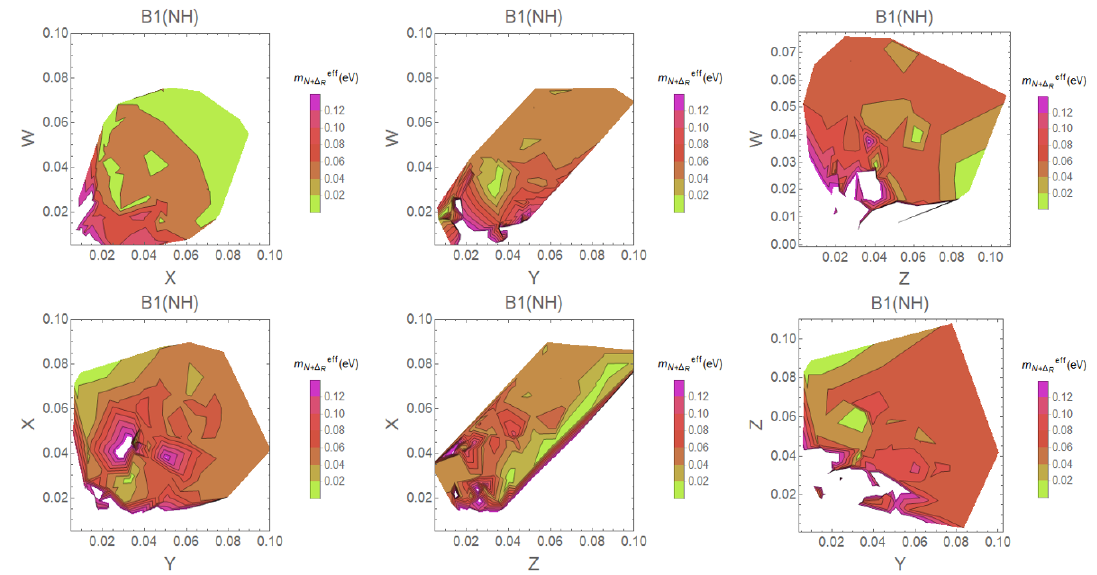
Figure 12 . The various combinations of type II SS model parameters (in eV) with the new physics contribution to e(cid:11)ective mass as the contour, where 0.061 eV is the KamLAND-Zen upper limit in B1 class of two texture zero neutrino mass matrix for normal hierarchy. Figure 13 . The various combinations of type II SS model parameters (in eV) with the new physics contribution to e(cid:11)ective mass as the contour, where 0.061 eV is the KamLAND-Zen upper limit in B1 class of two texture zero neutrino mass matrix for inverted